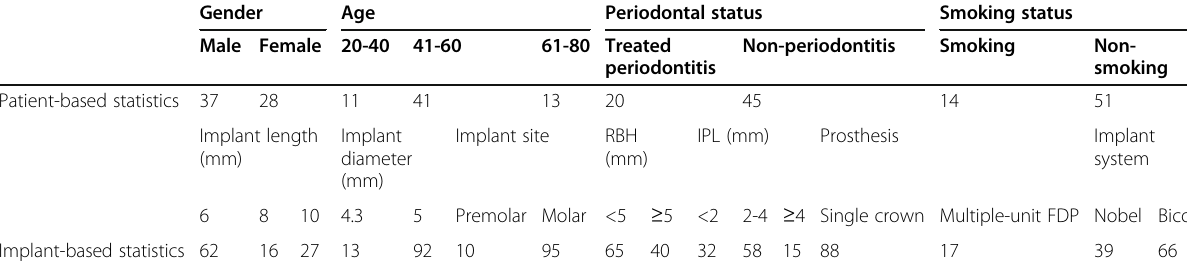
Table 1 Patient and implant characters and distributions Gender